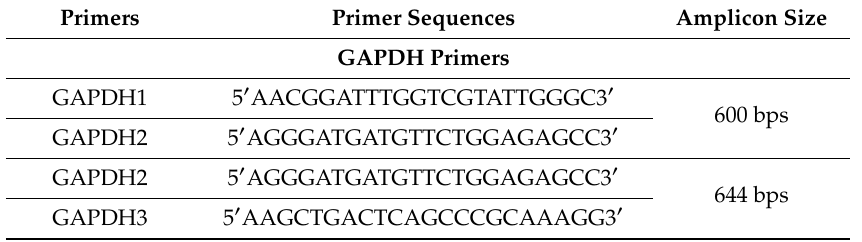
Table 1. Primers used in end-point PCR and quantitative PCR based on SYBR ® Green